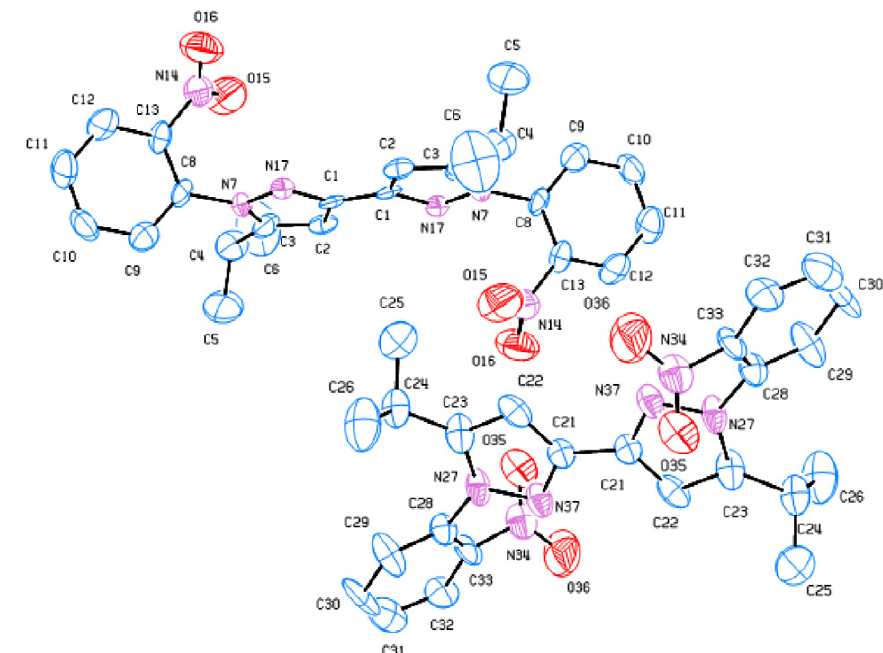
Fig. 2. Representation of the independent molecules of 1 . The H atoms are omitted for clarity.